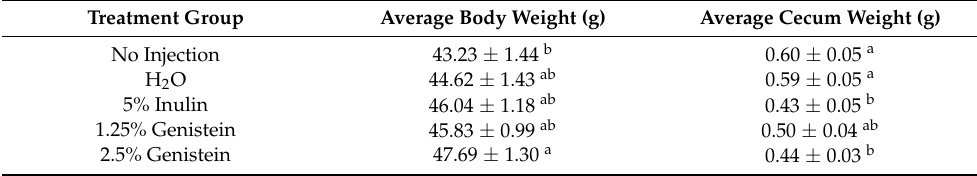
Table 2. Effect of genistein exposure on body weight and cecum weight 1 .